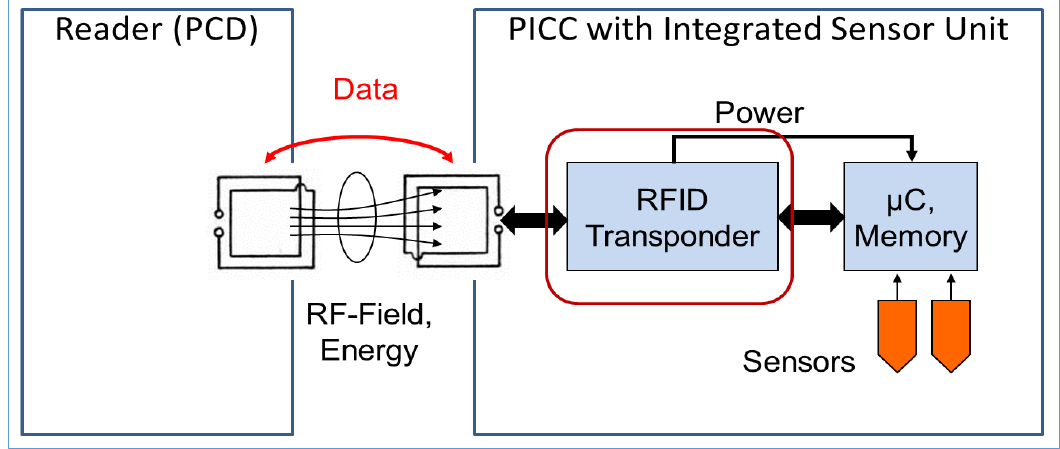
Figure 1. Block diagram of a RFID sensor system. The RFID transponder IC can be replaced by direct integration into the